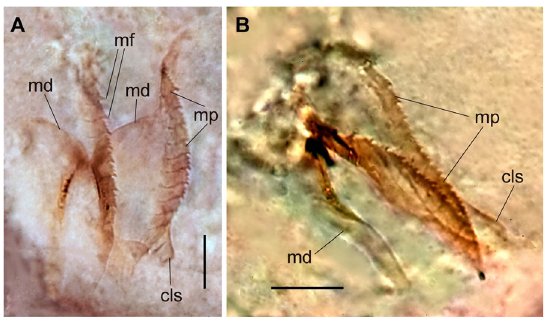
Fig 22. Meiodorvillea jumarsi sp. nov. (A,B) jaw apparatus, dorsal view. Abbreviations: md = mandibles; mf = main fang; mp = maxillary plates; cls = carrier-like-structure. Scale bars: (A,B) = 20 μ m.